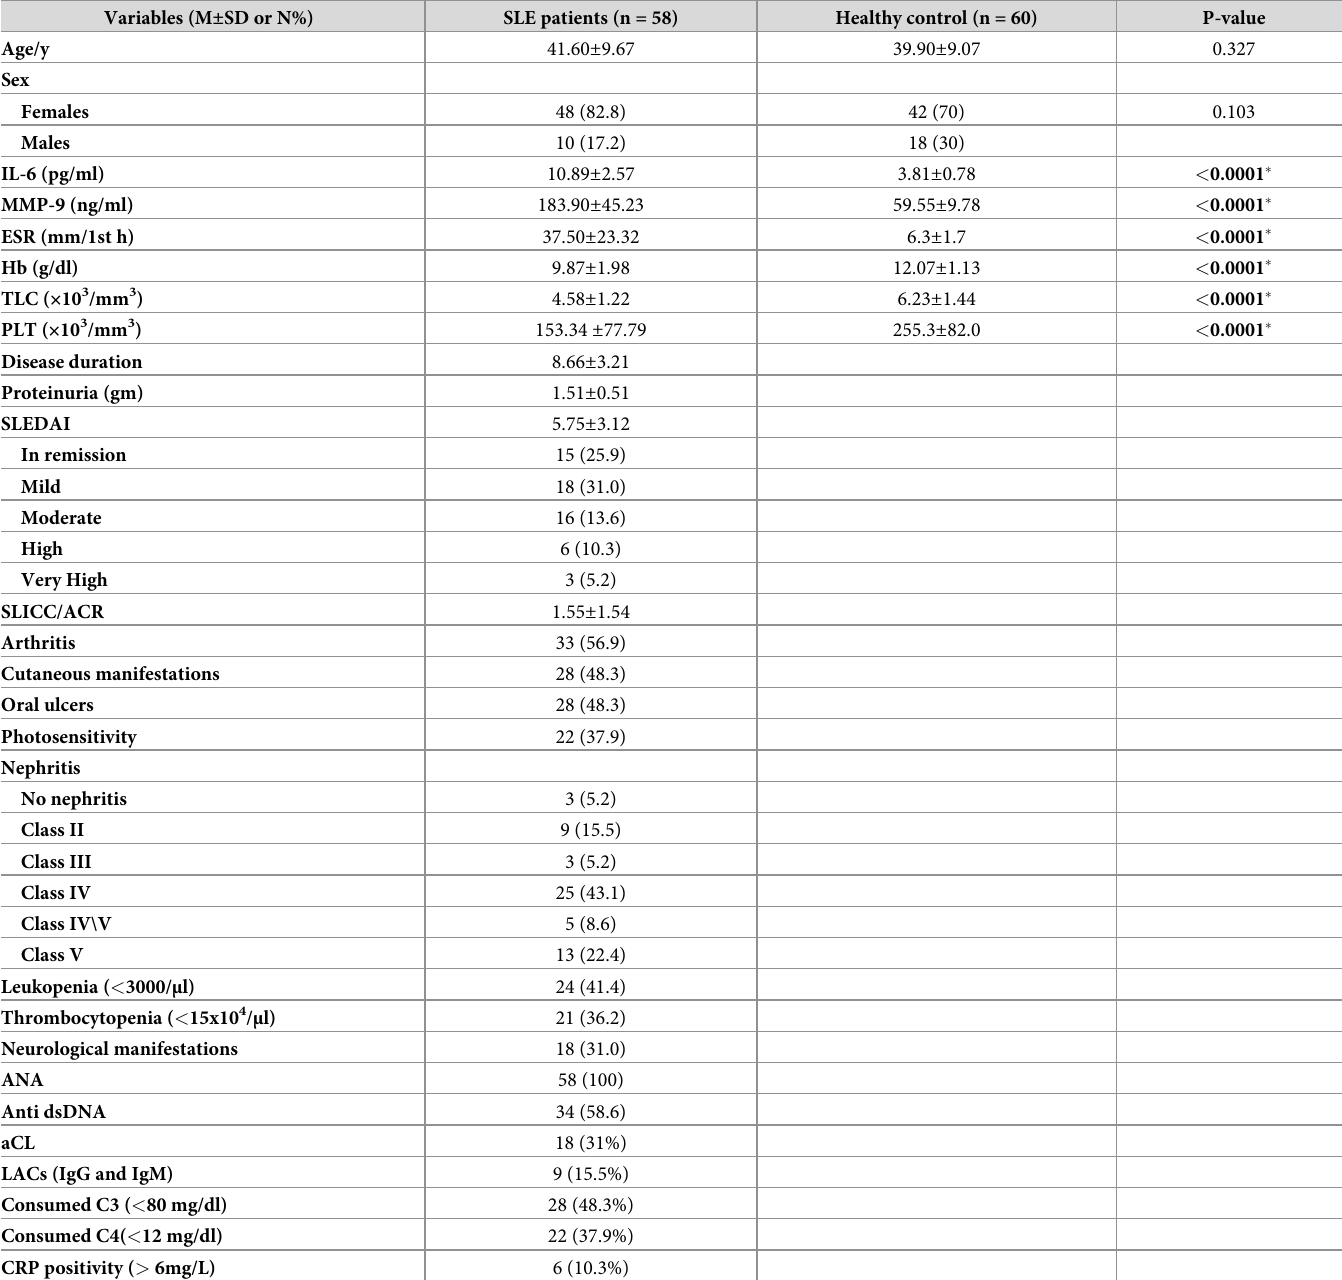
Table 1. Demographic, clinical and laboratory data of systemic lupus erythematosus (SLE)